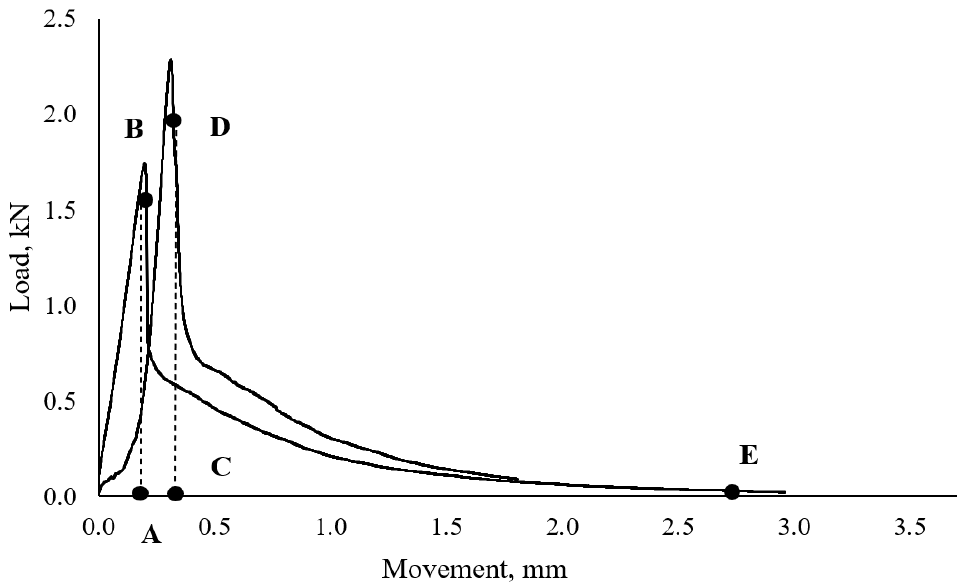
Figure 15. Load–displacement curves of cut faces of concrete with 5 kg/m 3 of fiber content.